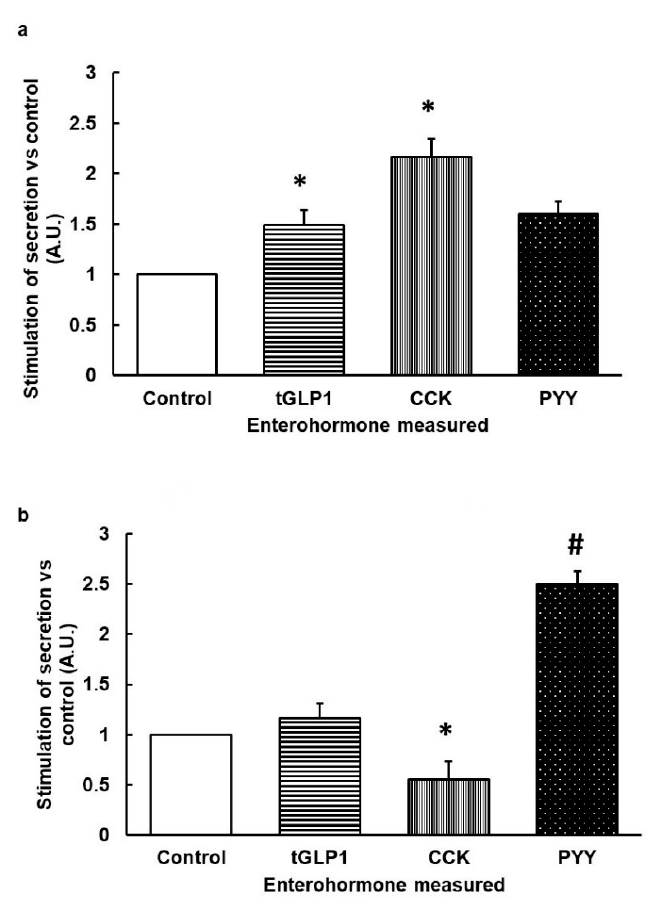
Figure 1. Ex vivo stimulation of enterohormone secretions induced by 1,10-Phenantroline ( a ) or Thiamine ( b ). Rat segments of duodenum (for cholecystokinin (CCK)) and ileum (for total glucagon-like peptide 1 (tGLP1) and peptide YY (PYY)) were treated with 1,10-Phenantroline 150 µM for 30 min ( a ) or Thiamine 1 mM for 30 min ( b ). Afterwards, medium was collected and respective enterohormones were quantified by ELISA ( n = 6–10 segments). Results are calculated versus basal respective secretion in each hormone (Arbitrary Units, A.U.). Mean ± SEM. * denotes p < 0.05 vs. control; # indicate p < 0.1 vs. control.